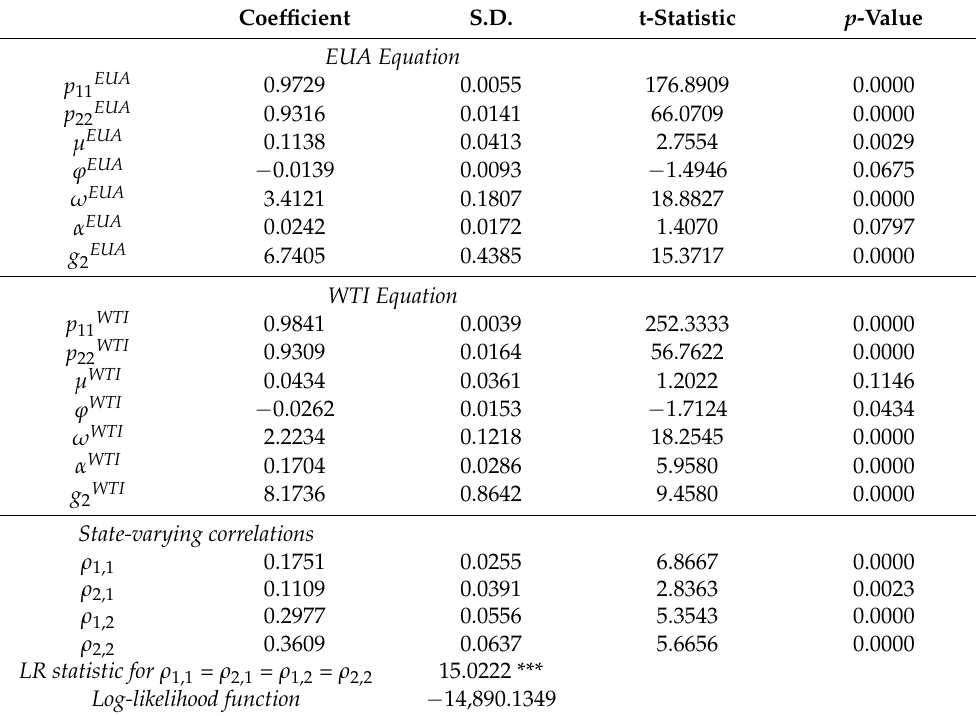
Table 5. Estimated results of the bivariate SWARCH model with state-varying